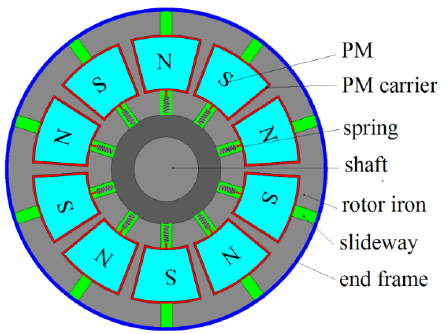
Figure 2. Schematic diagram of the novel rotor with sliding PMs.